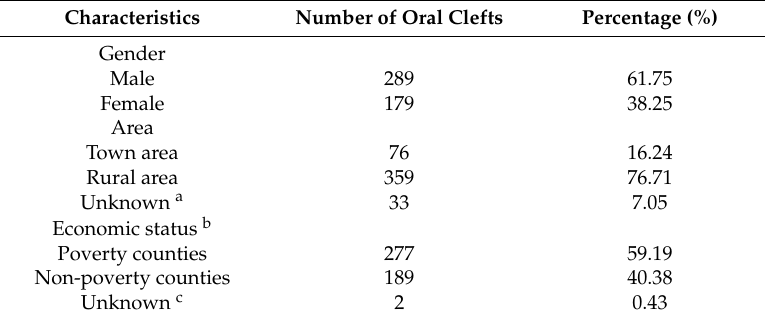
Table 2. The distribution of oral clefts in 2008 in Gansu Province.